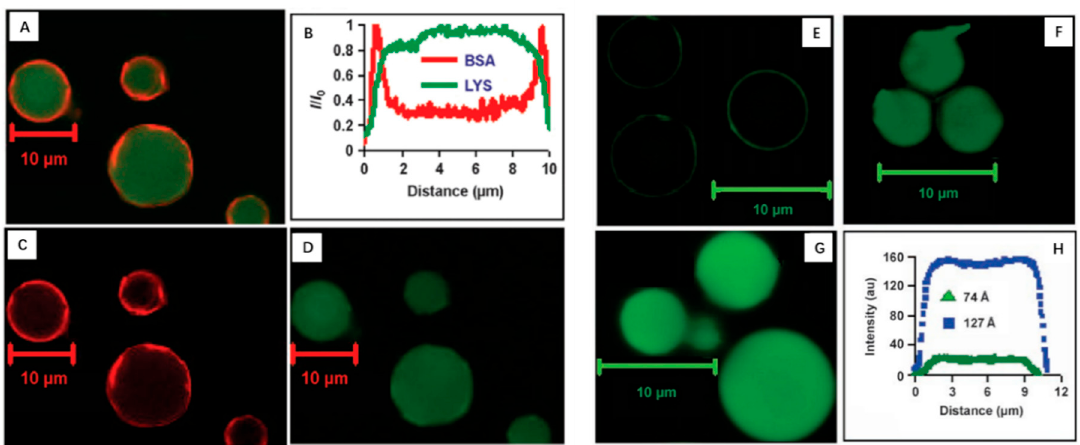
Figure 1. The pore size-selective adsorption and separation of proteins on spherical SBA-15 mesoporous silica nanoparticles (MSN) at pH7.1 ( A – D ). ( A ) Merge confocal scanning laser microscopy (CLSM) image of protein adsorbed in SBA-15 (127 Å) (red, Texas Red labeled bovine serum albumin (BSA); green, Alexa Fluor 488 labeled lysozyme (LYS)). ( B ) Normalized protein density along with distance. ( C ) BSA image. ( D ) LYS image. The LYS adsorption in SBA-15 MSN with different pore sizes ( E – H ). ( E ) SBA-15 MSN (28 Å). ( F ) SBA-15 MSN (74 Å). ( G ) SBA-15 MSN (127 Å). ( H ) LYS intensity in 74 Å and 127 Å SBA-15 [55] .